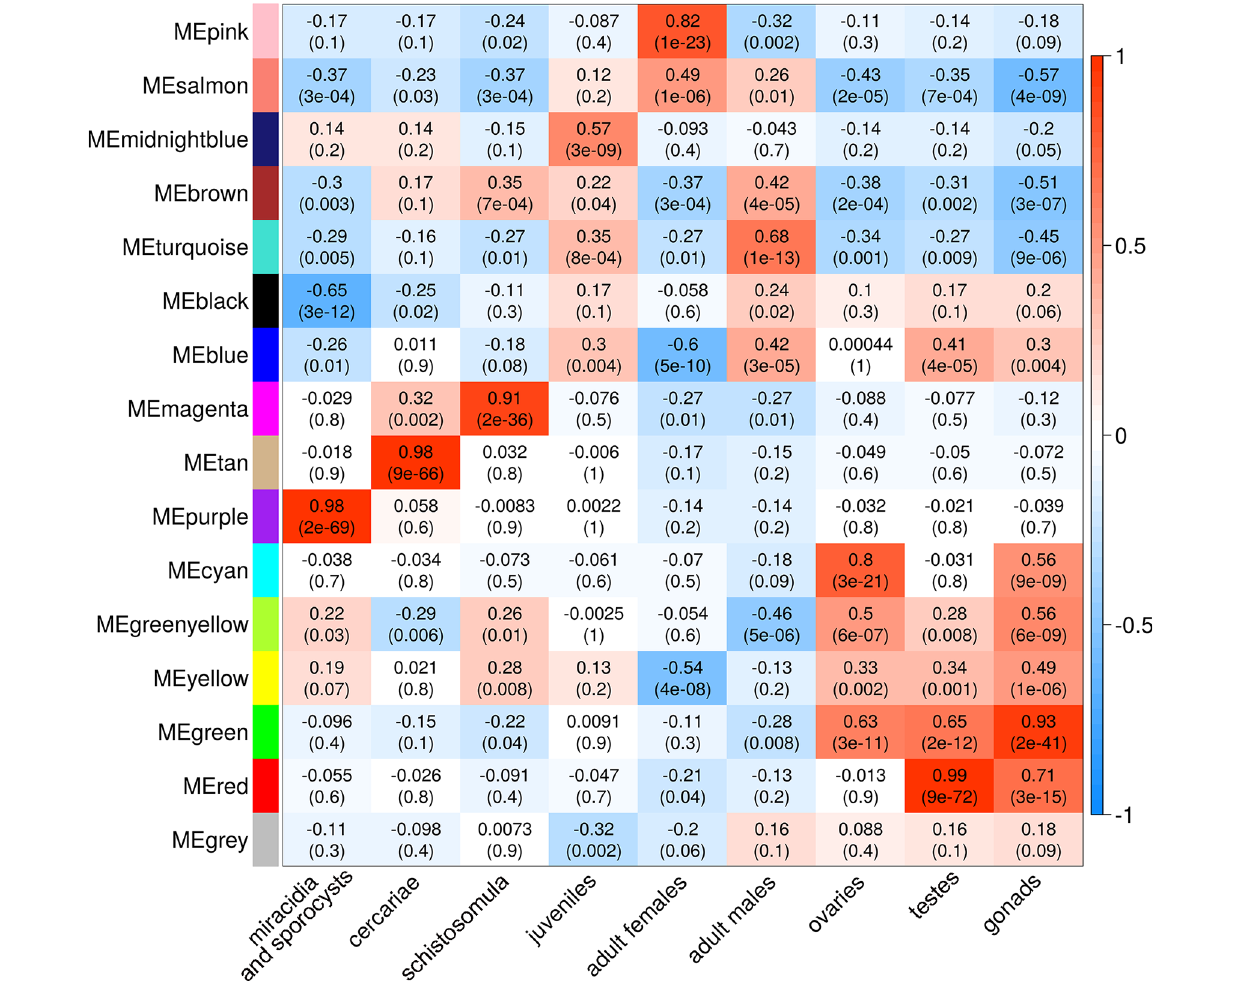
FIGURE 8 | Each parasite life-cycle stage (or tissue) has at least one highly correlated gene co-expression module. Each cell in the table shows the Pearson correlation (with the p-value in parenthesis) between each of the 15 co-expression modules determined by WGCNA (indicated at left) and the stages/tissues of S. mansoni (indicated at the bottom). The cells are colored according to the scale (at right), which is related to the Pearson correlation